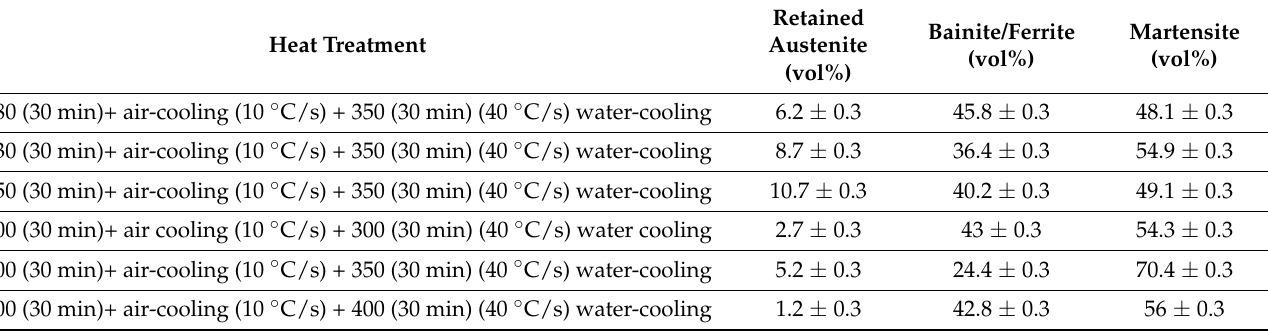
Table 3. Results of phase quantification performed by Rietveld